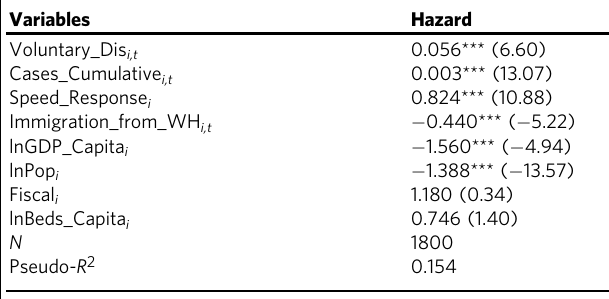
Table 4 Duration of local epidemic and government